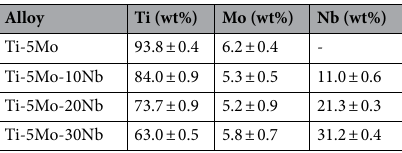
Table 1. Semiquantitative chemical composition of the Ti-5Mo-Nb system alloys, by EDS.